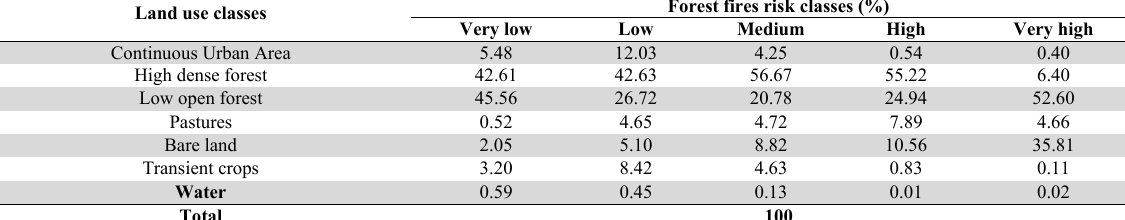
Spatial relationship between forest fires risk classes and land use in Amojú river basin.